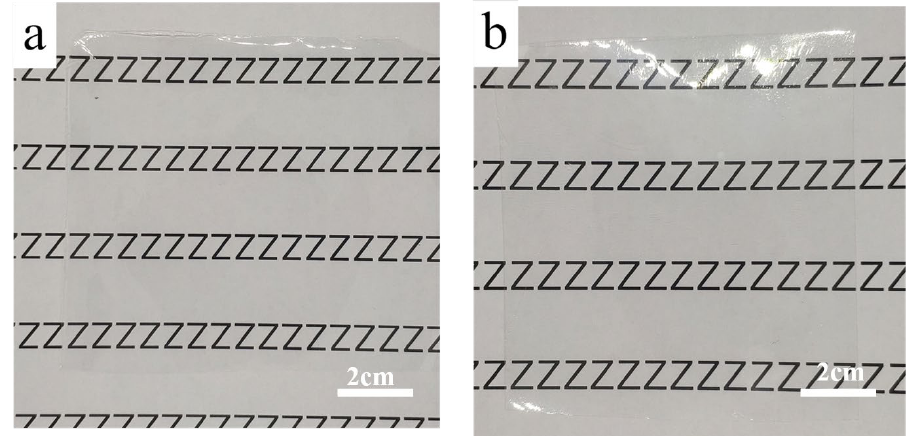
Figure 5. Appearance images of SA film and LBL2 film (( a ): SA film; ( b ): LBL2